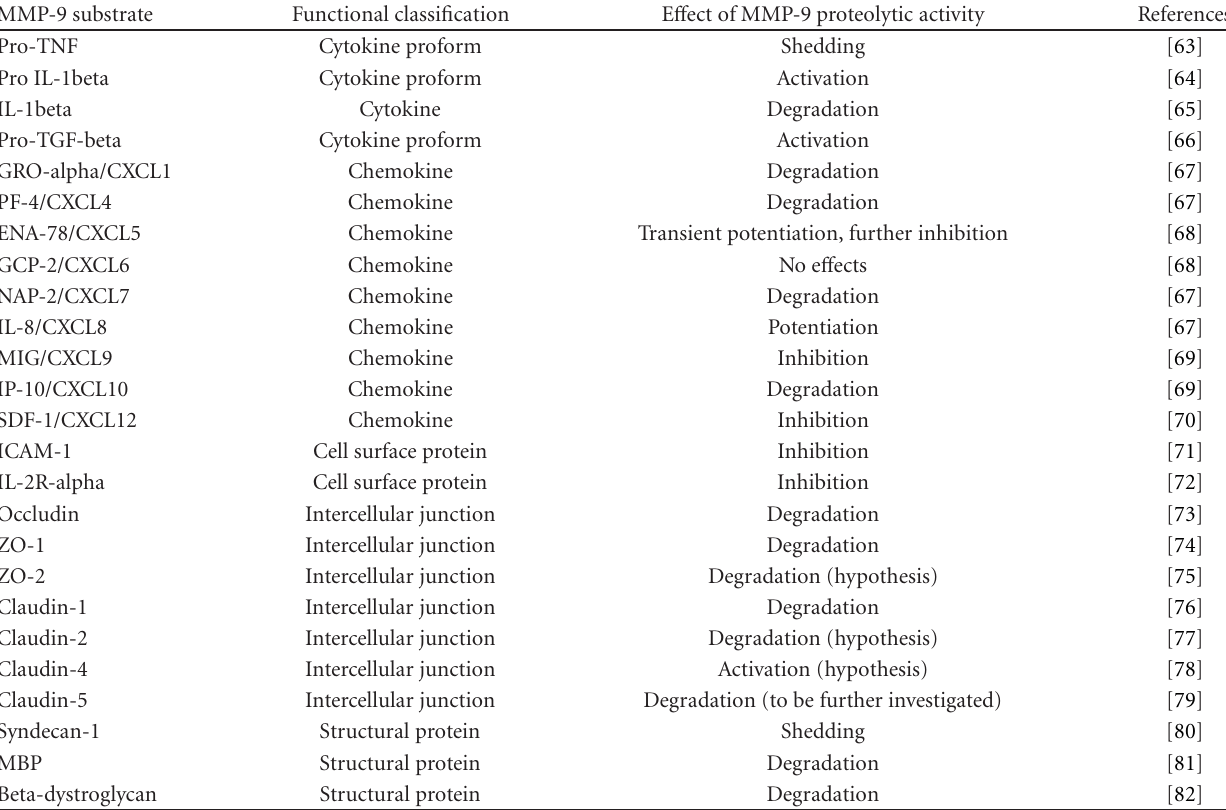
Table 1: Substrates of MMP-9 that might be critical to complicated severe